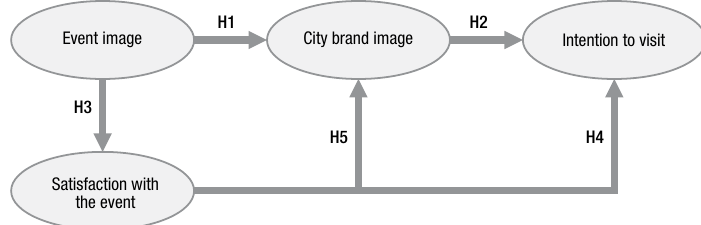
Fig. 2. Diagram showing the five hypotheses to be tested and their relationships